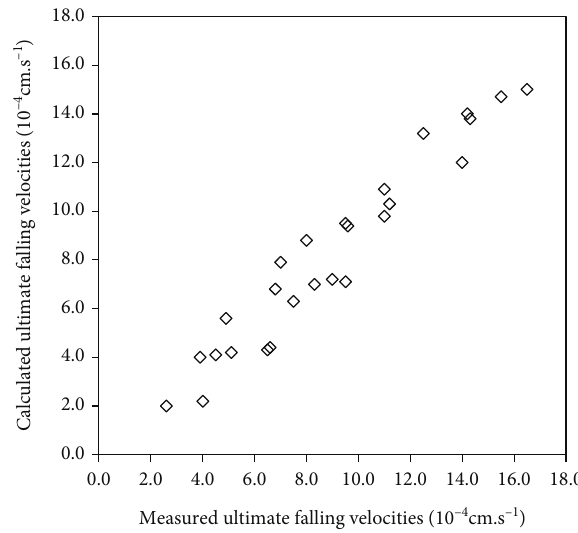
Figure 3: Comparison of the simulated and measured ultimate falling